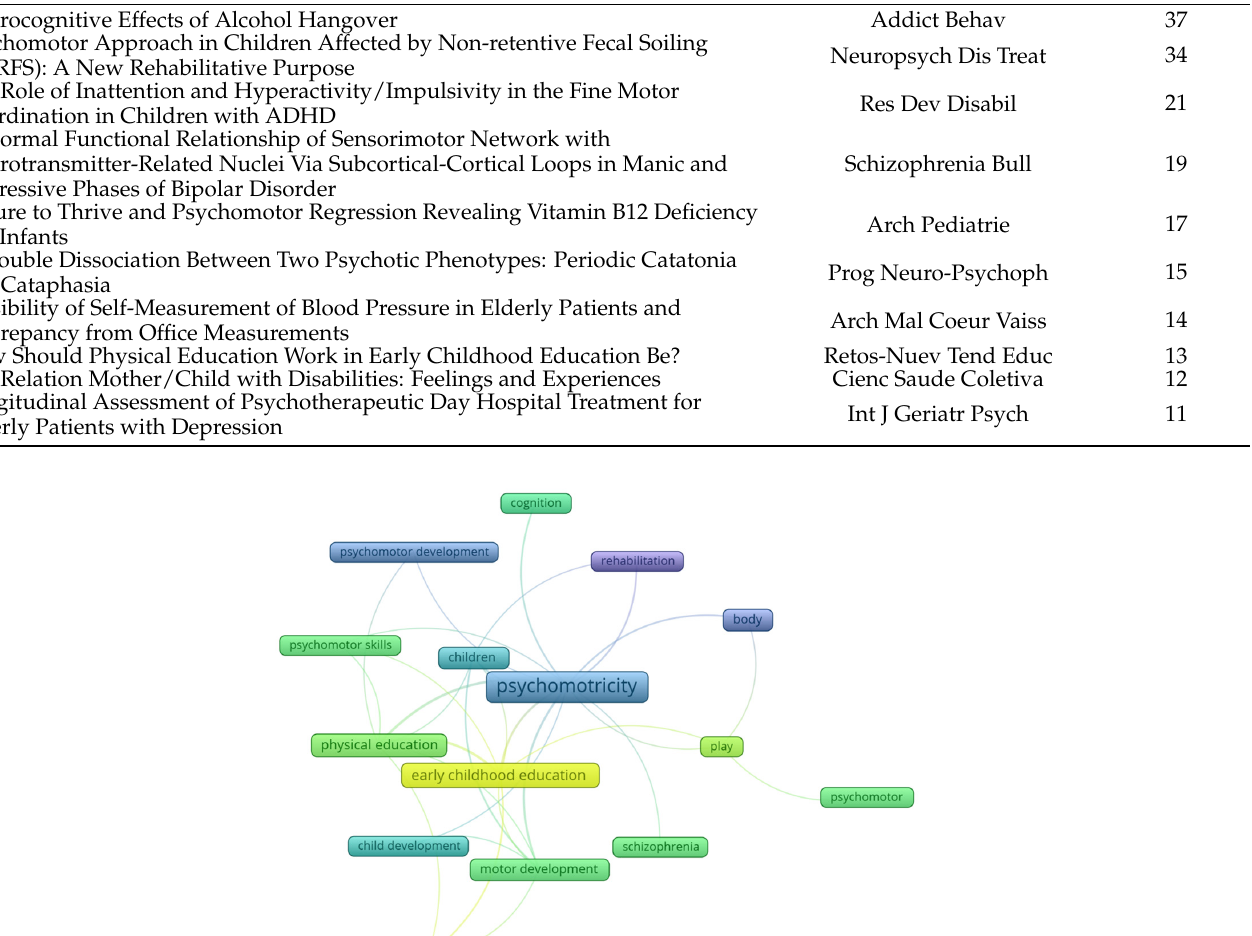
Table 3. More cited documents in psychomotricity.